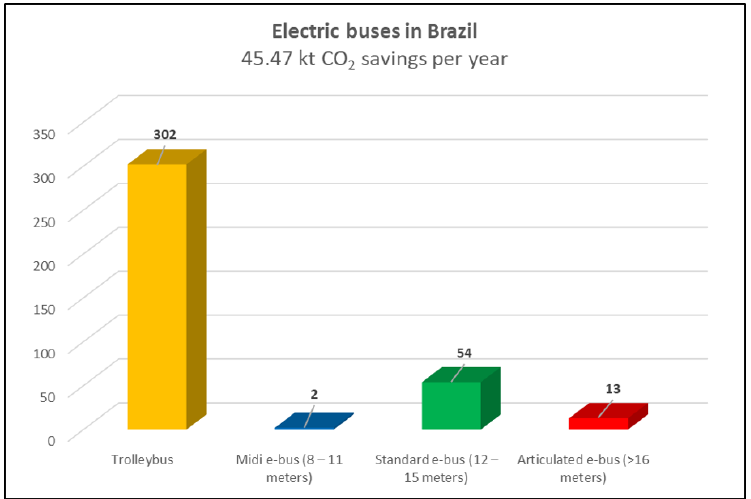
Figure 1. Electric buses in Brazil according to [21]. Data from February